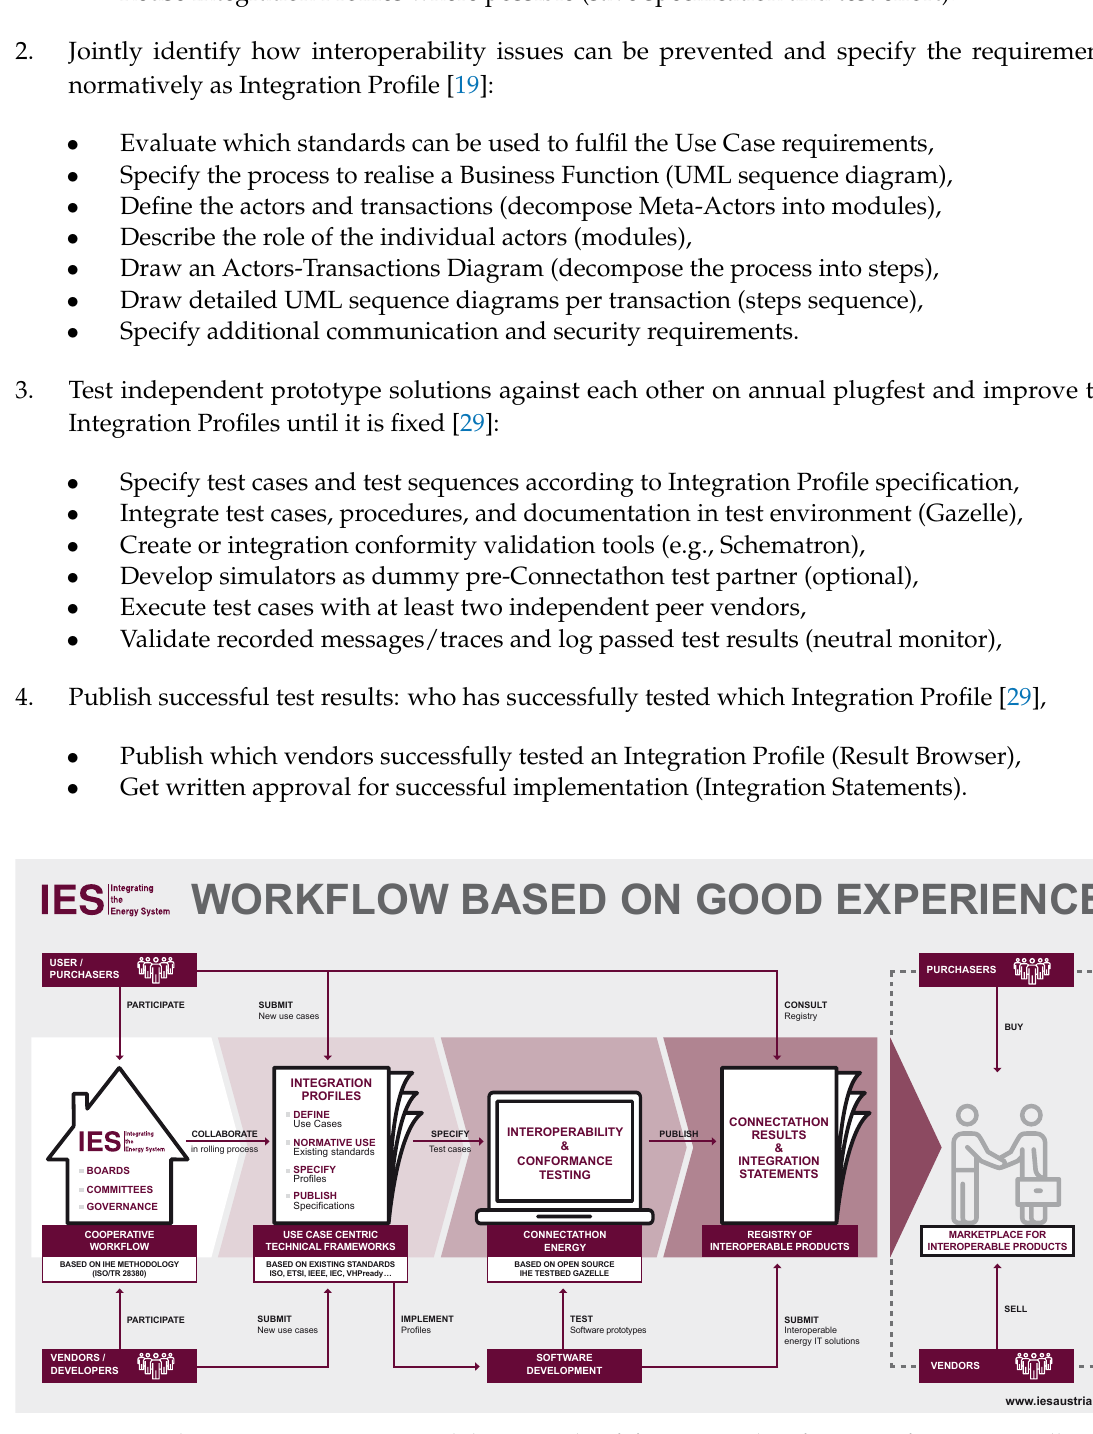
Figure 5. The IES process to interoperability are, in brief, four steps: identify → specify → test → sell. Integration Profiles shall be living documents that improve and grow until they become